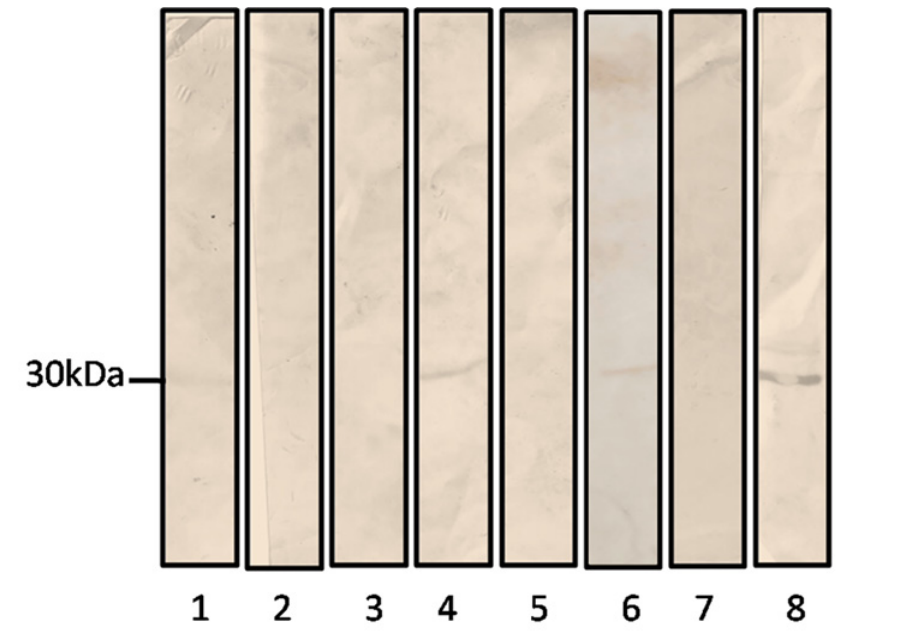
Fig 3. Immunoblotting was performed using the anti-Pb14-3-3 polyclonal antibody to verify 14-3-3 protein reactivity. Cytoplasmic fraction from P. brasiliensis grown in Fava Nettós media (1), cell wall fraction from P. brasiliensis grown in Fava Nettós media (2), and A549 cells infected with P. brasiliensis for 2 h (4), 5 h (6) and 8 h (8). The control was performed using noninfected A549 cells for 2 h (3), 5 h (5), and 8 h